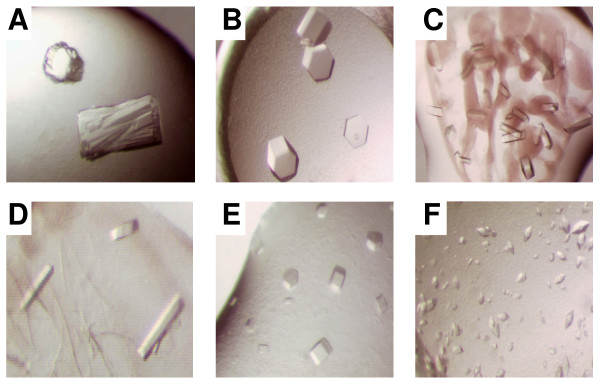
Crystallization of FtsZ. Protein crystals of FtsZ obtained under different condtions are shown: A, 1.26 M (NH4)2SO4, 100 mM MES pH 6.5. B, 1.26 M (NH4)2SO4, 100 mM Hepes pH 7.5. C, 30% (v/v) PEG-200, 100 mM MES pH 6.0, 5% (w/v) PEG-3000. D, 20% (w/v) PEG-8000, 100 mM Hepes pH 7.5. E, 1.26 M (NH4)2SO4, 100 mM Hepes pH 7.5. F, 50% (v/v) PEG-200, 100 mM Tris pH 7.0, 0.05 M Li2SO4.